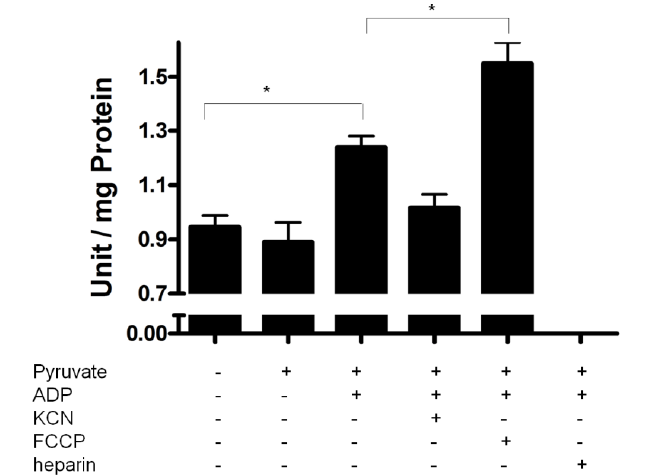
Figure 3. Regulation of mitochondrial PPX activity during mitochondrial respiration. PPX activity was measured in mitochondria of the eggs on the 9th day of development during mitochondrial respiration, using pyruvate as oxidative substrates, polyP KCN as inhibitor of the respiratory chain, FCCP as uncoupler and Heparin as PPX inhibitor. The activity was expressed as units per milligram of total protein and the results represent mean ± SD. of three independent experiments, in triplicate. Asterisk (*) denotes the difference between population and the significance was determined by two way ANOVA test